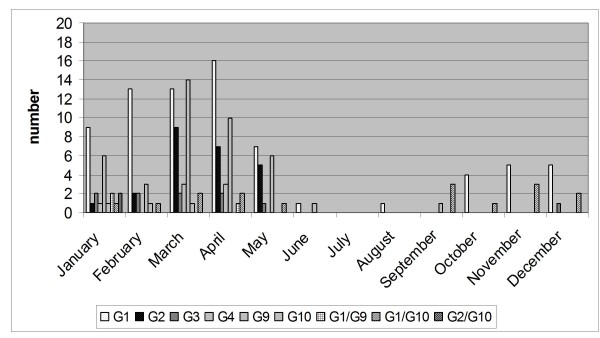
Number of typed rotavirus G genotypes by month, in the area of Milan, northern Italy.